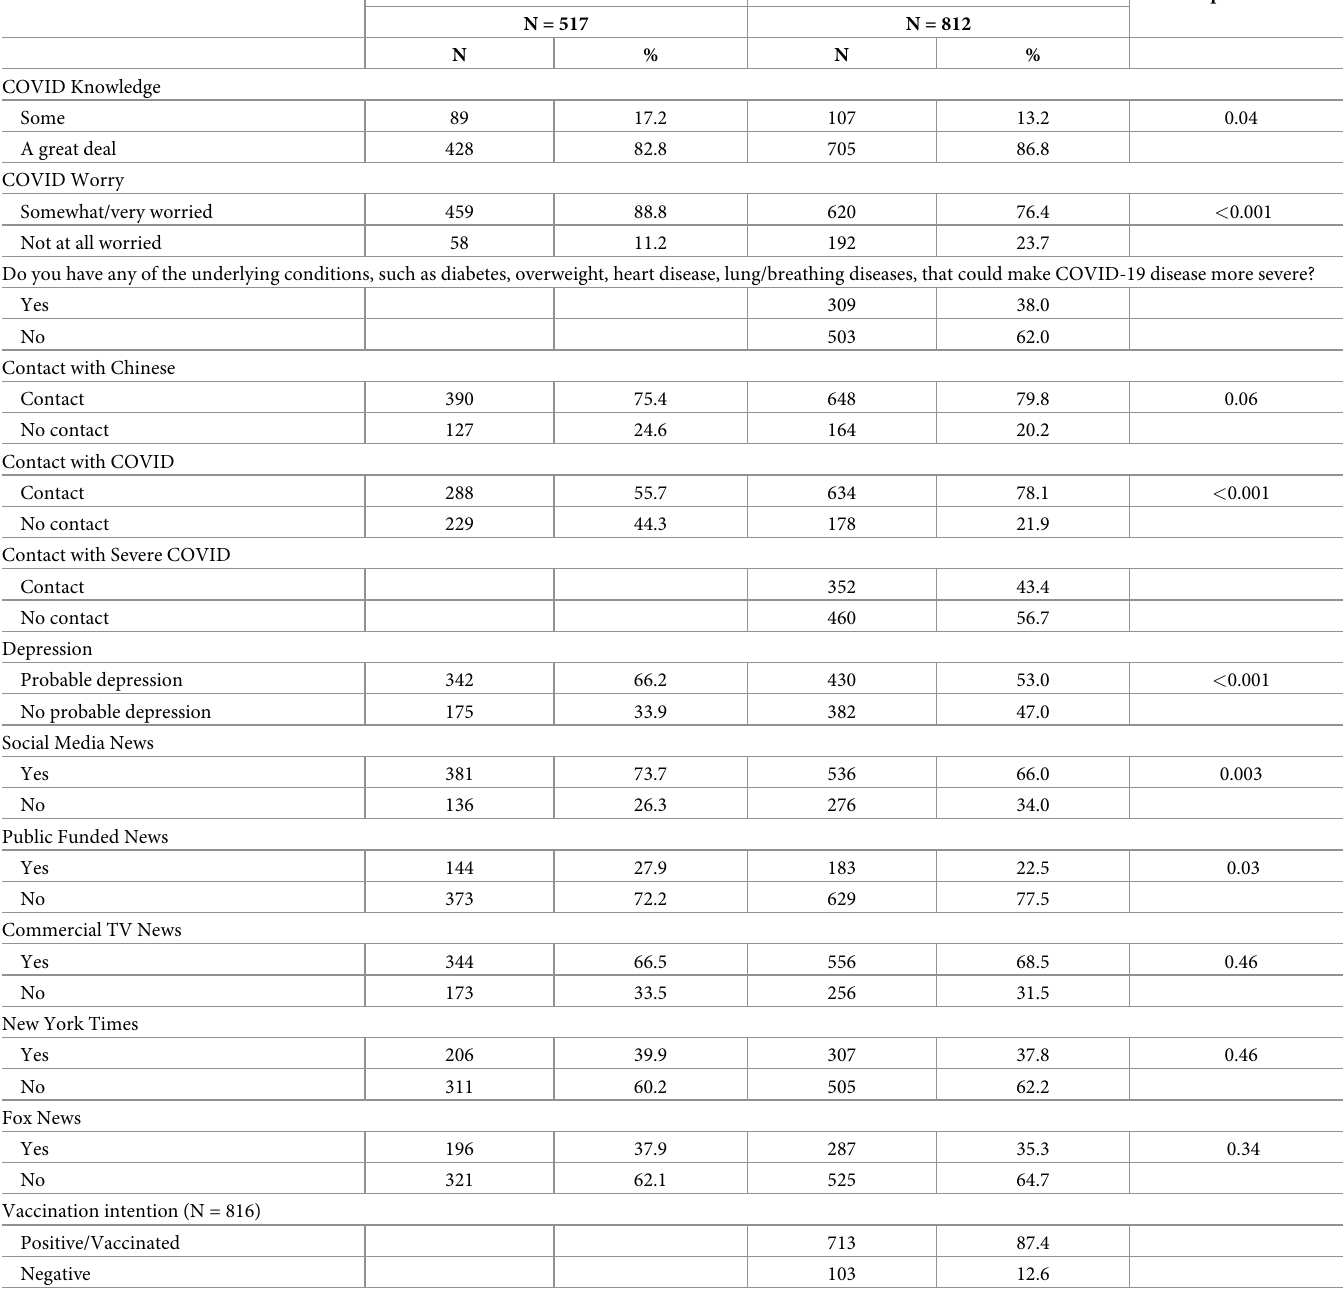
Table 4. COVID-19 related experiences and vulnerabilities for Waves 1 (N = 517) and 2 (N =